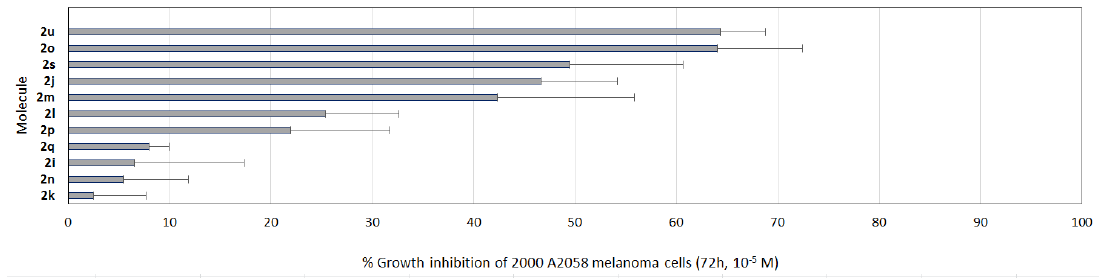
Figure 2. Antiproliferative activity of some of the synthesized compounds at 10 − 5 M after 72 h in A2058 human melanoma cells.